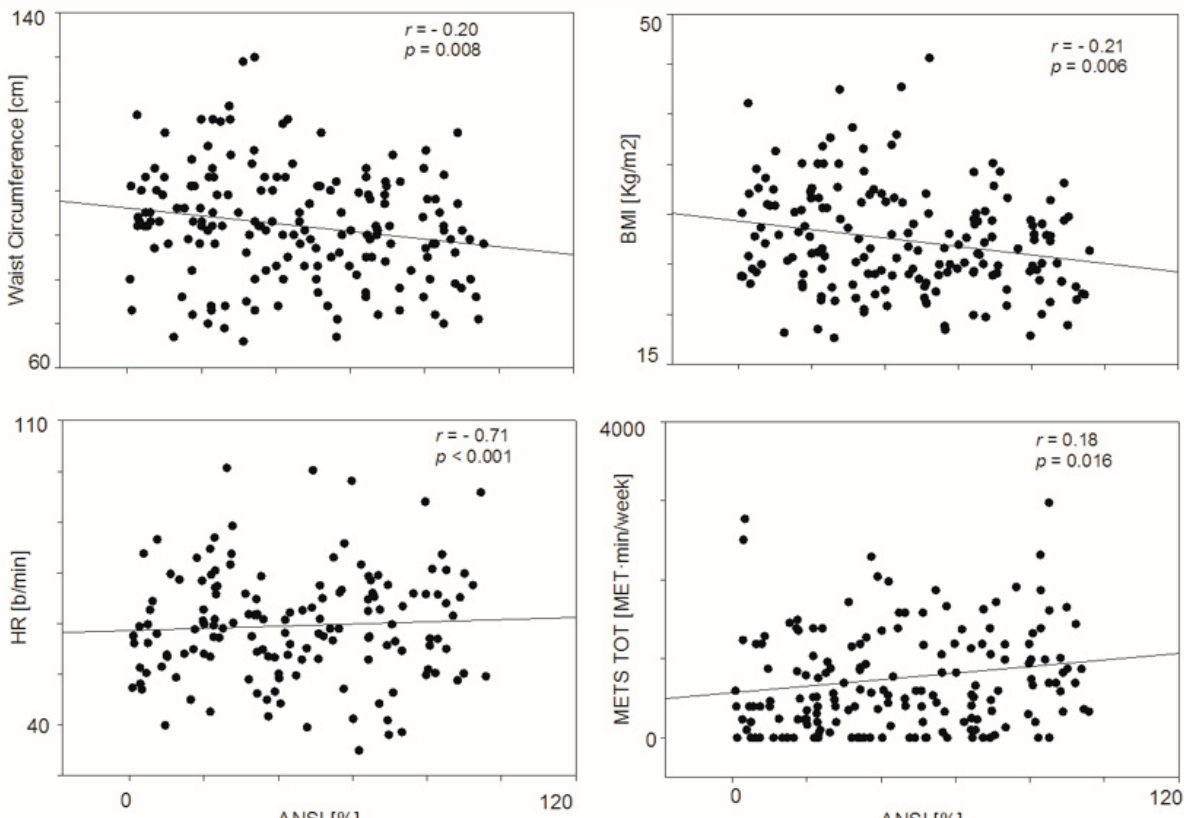
Figure 3. Scatterplot ANSI against waist circumference, BMI, heart rate and total activity volume (METs TOT).